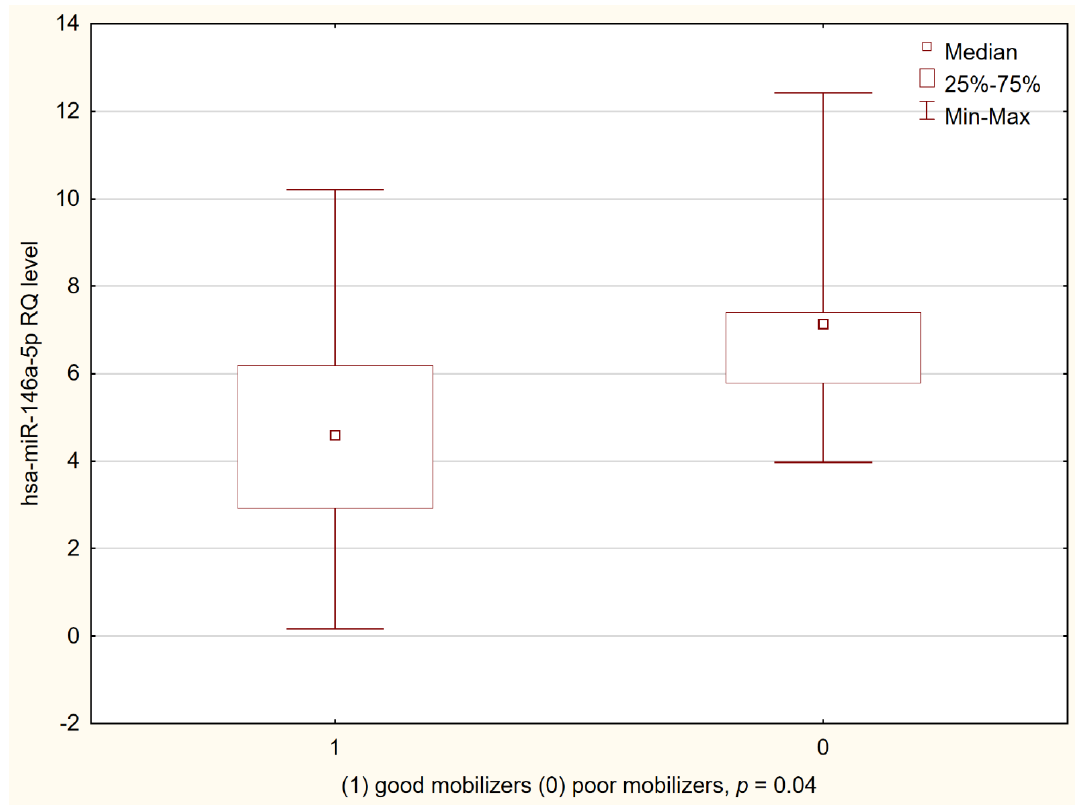
Figure 3. hsa-miR-146a-5p expression on the day of the first apheresis in patients divided into “good” and “poor” mobilizers according to GITMO criteria.